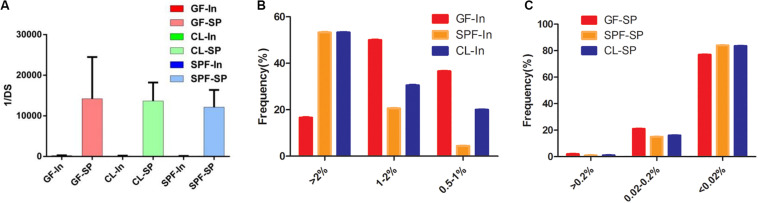
Expansive of total Treg TCR beta CDR3 clones in spleen and intestine. (A) The inverse Simpson’s diversity index average distribution; (B,C) Expansive degree in spleen and intestine. GF, Germ-free class mice; SPF, Specific Pathogen-free mice; CL, Clean Class mice. SP, spleen; In, intestine.